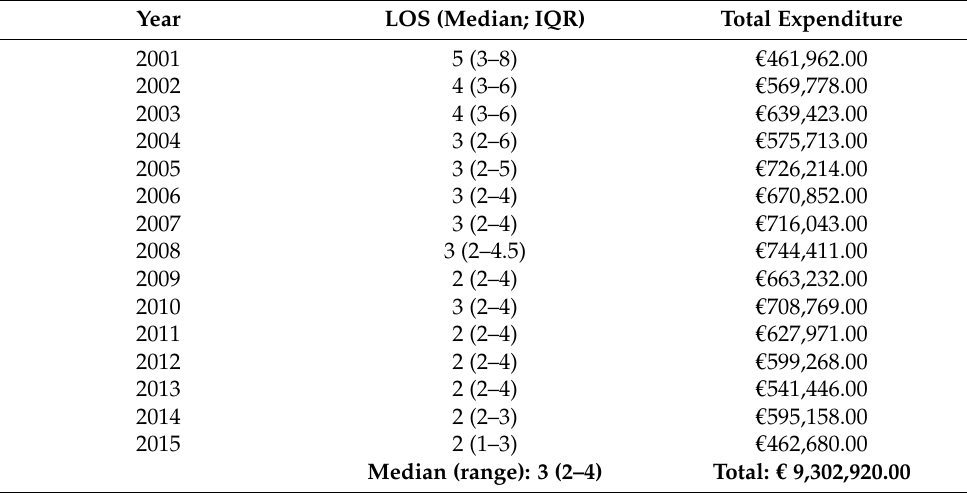
Table 2. Length of stay and healthcare expenditures for PCL